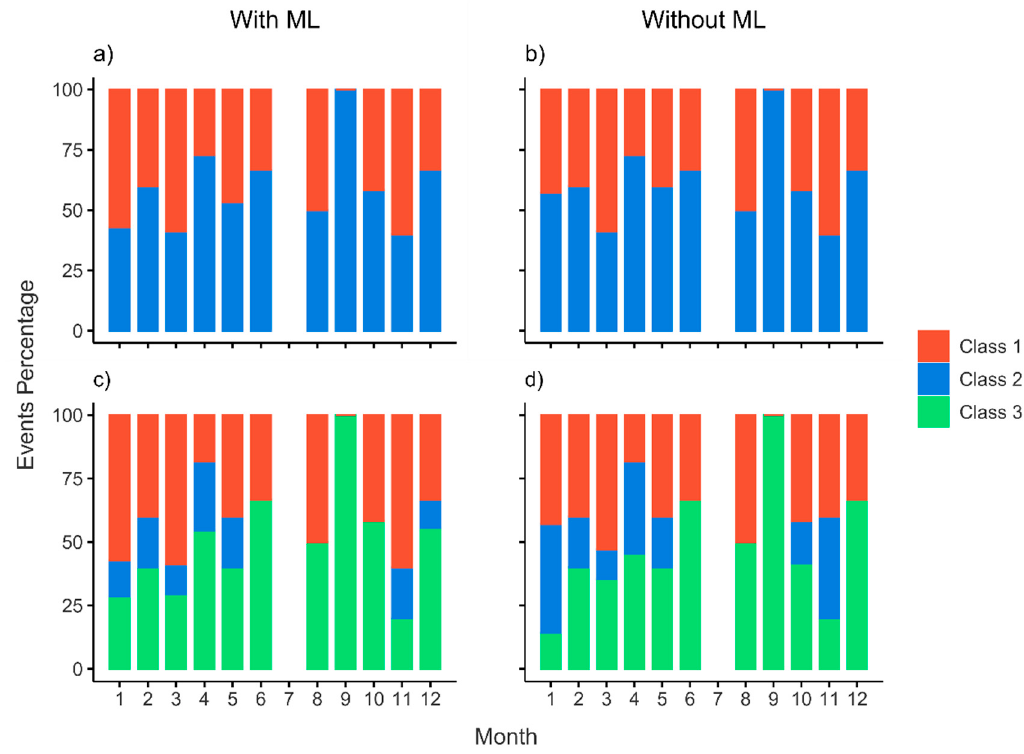
Figure 10. Monthly event percentage for two classes: ( a ) with ML feature, ( b ) without ML feature. Events for three classes: ( c ) with ML feature, ( d ) without ML feature.